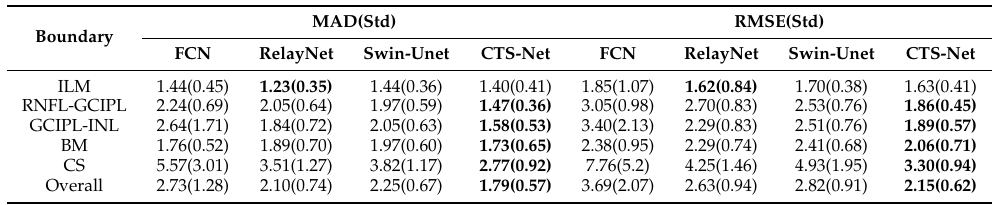
Table 1. Test results of MAD(Std) and RMSE(Std) of each method in the GOALS dataset, where Std means standard